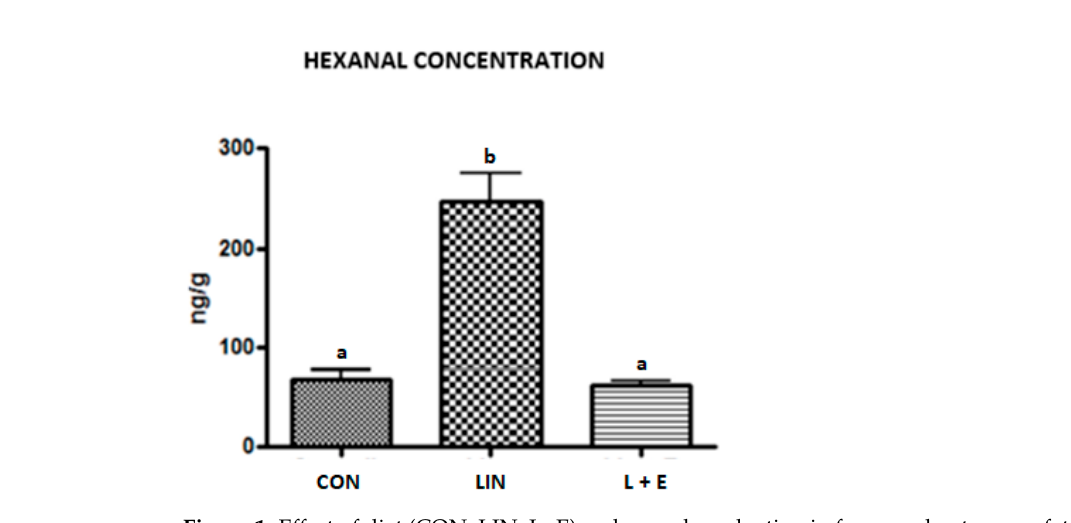
Figure 1. Effect of diet (CON, LIN, L+E) on hexanal production in frozen subcutaneous fat of young bulls of Charolaise × Podolica by chromatography/mass spectrometry (GC/MS). Different letters are statistically different for p < 0.001. Table 5. Color of the Longissimus thoracis of Charolaise × Podolica young bulls according to the diet (DIET) and the day of storage